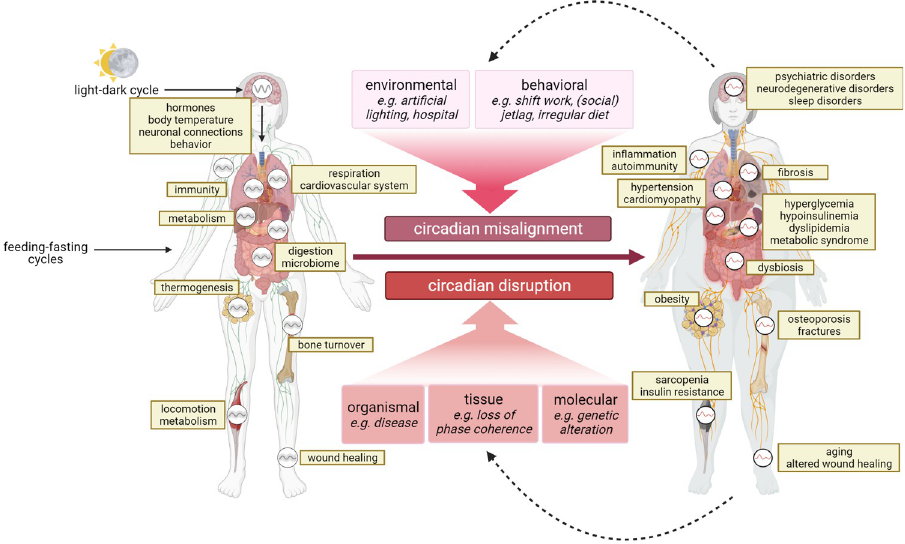
Fig 1. Circadian misalignment and disruption are associated with disease. Circadian rhythms are present at the level of the individual cell, tissue, and system and contribute to the optimal temporal coordination of physiological organ functions with environmental entrainment signals (left). It is therefore not surprising that misalignment of endogenous circadian and exogenous environmental cycles, as well as disruption of endogenous circadian rhythmicity is associated with or increases the risk for many diseases (right). Moreover, by contributing to circadian disruption or by altering behavioral rhythms, disease may in turn aggravate pathologies related to dysfunction of the circadian system (created with